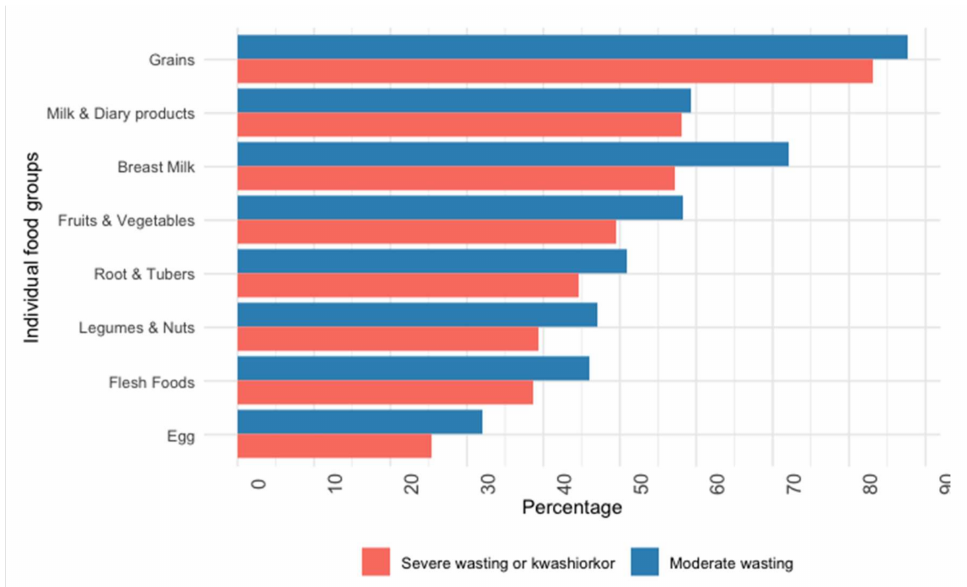
Figure 3. The proportion of specific food group consumption by nutritional